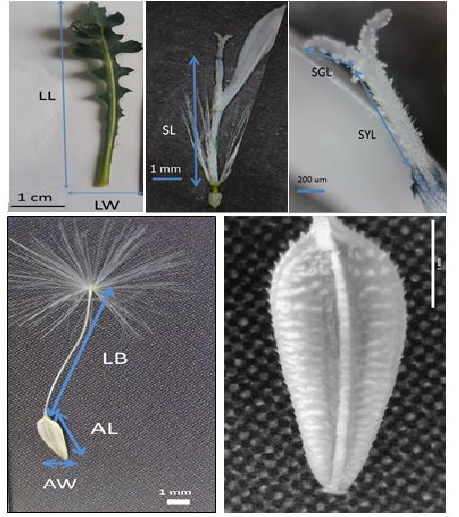
Fig. 2. Morphological characteristics of L. undulata :LL= leaf length; LW= leaf width; SL= stamen length; SGL= Stigma length; SYL= style length; LB= length of beak; AL= achene length; AW= achene width; Achene of a sample from Biarjmand